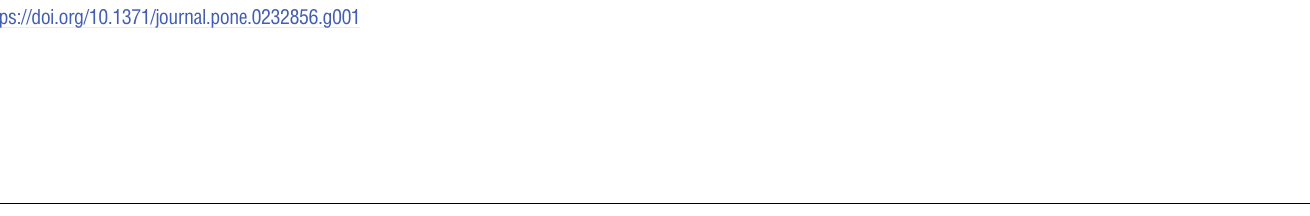
PLOS ONE | https://doi.org/10.1371/journal.pone.0232856 May 6,